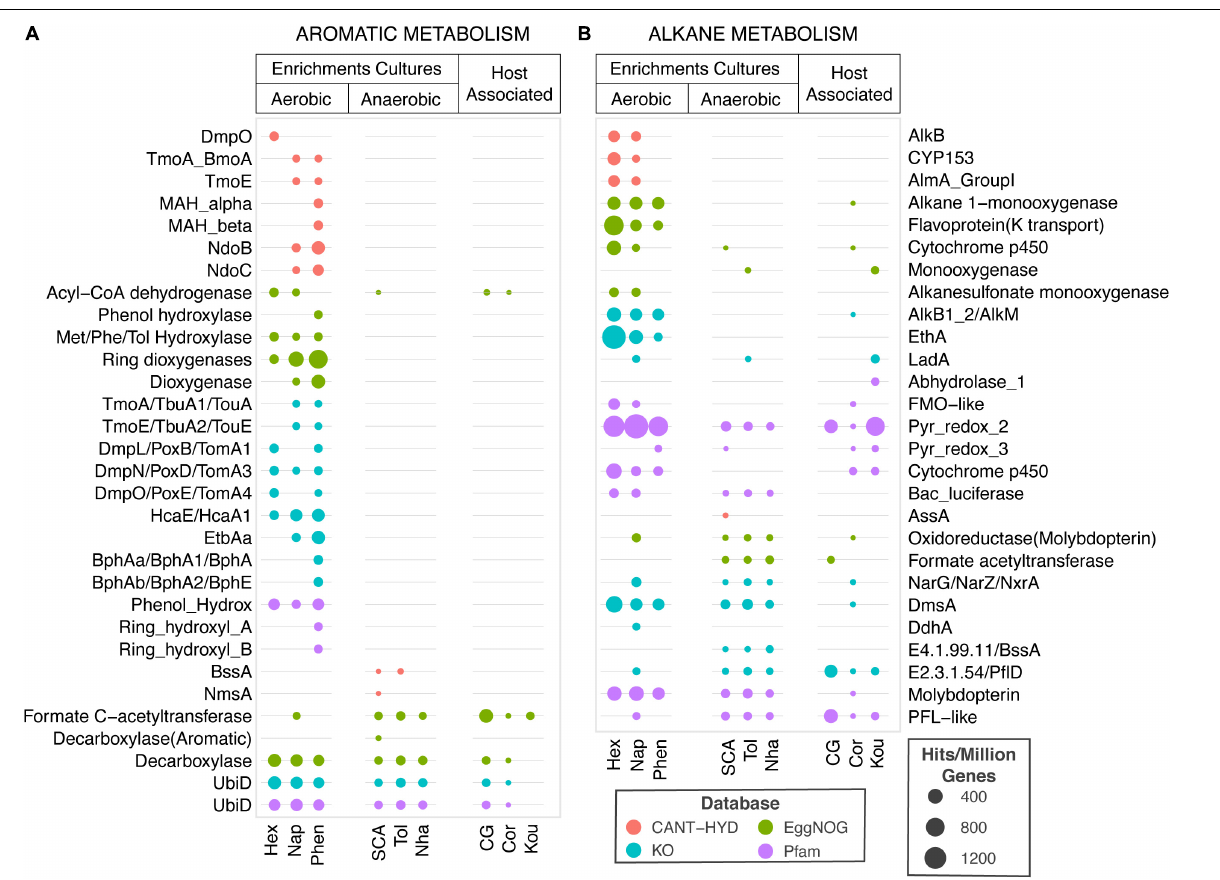
FIGURE 7 | Comparison of hydrocarbon metabolism prediction in metagenomes. Hits to aromatic hydrocarbon (A) and alkane (B) metabolism HMMs (y-axis) from CANT-HYD (red), eggNOG (green), KO (teal), and Pfam (purple) to each metagenome (x-axis) normalized to per million coding genes. The metagenomes (x-axis) are grouped under Enrichment Cultures or Host associated microbiome. The enrichment culture metagenomes representing microbial community grown on under aerobic conditions on hexadecane (Hex), naphthalene (Nap), or phenanthrene (Phen) or under anaerobic conditions on short-chain alkanes (SCA), Toluene (Tol), or Naphtha (Nha). The host-associated microbiomes are from child gut (CG), Coral (Cor), or Koumiss (Kou). The size of the bubble depicts proportion of hydrocarbon degrading genes to total genic content of the metagenome. See Supplementary Table 5 for details regarding the HMMs and the underlying